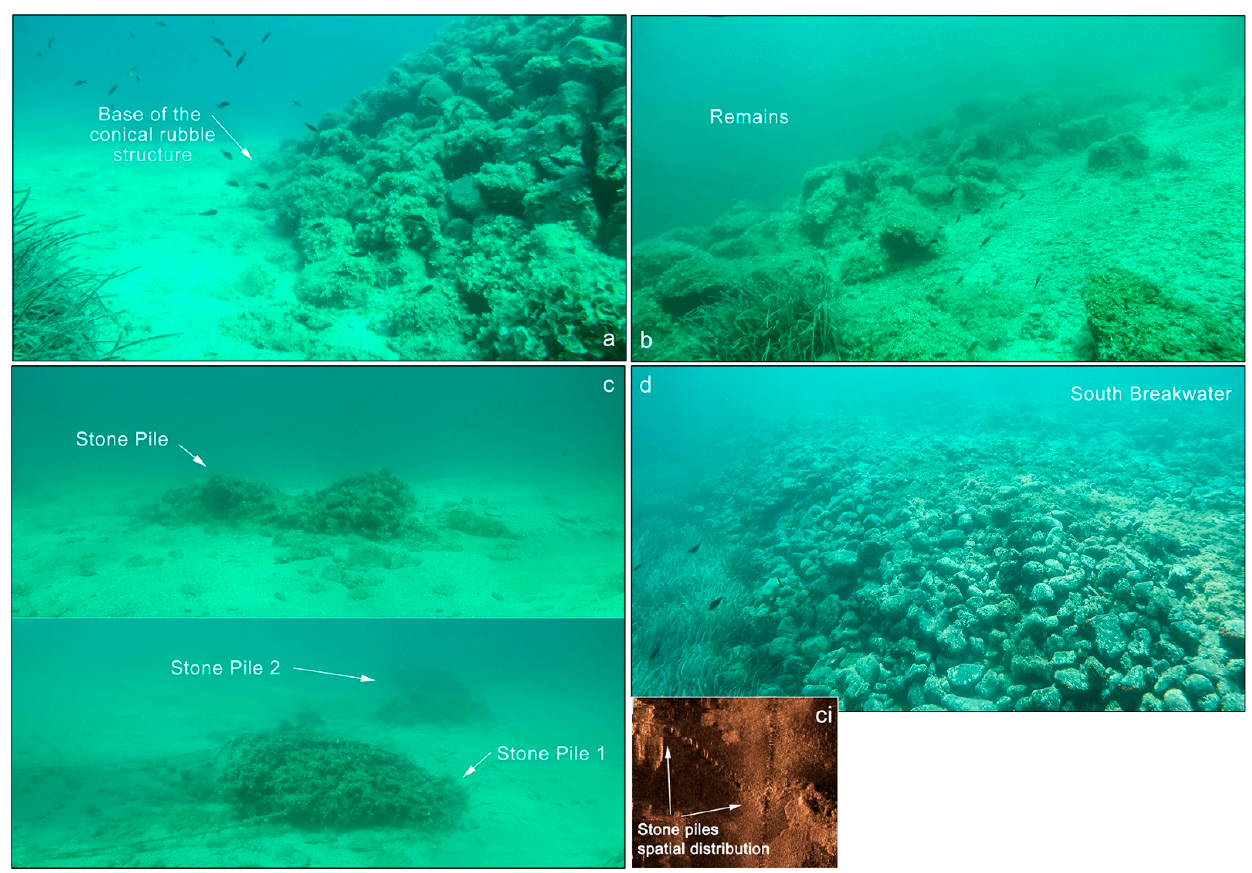
Figure 8. Ground-truthing photos of the submerged structures (their location is shown in Figure 7). ( a ) base of the conical rubble structure, ( b ) remains from the structures, ( c ) 2 of the stone piles constituting the linear structure at the south in line with the south breakwater, ( ci ) spatial distribution of the stone piles forming a linear feature, ( d ) southern breakwater. Finally, apart from the curved southern breakwater (Figure 7), a previously unknown complex pattern of structures is apparent. At the western edge of the south breakwater,